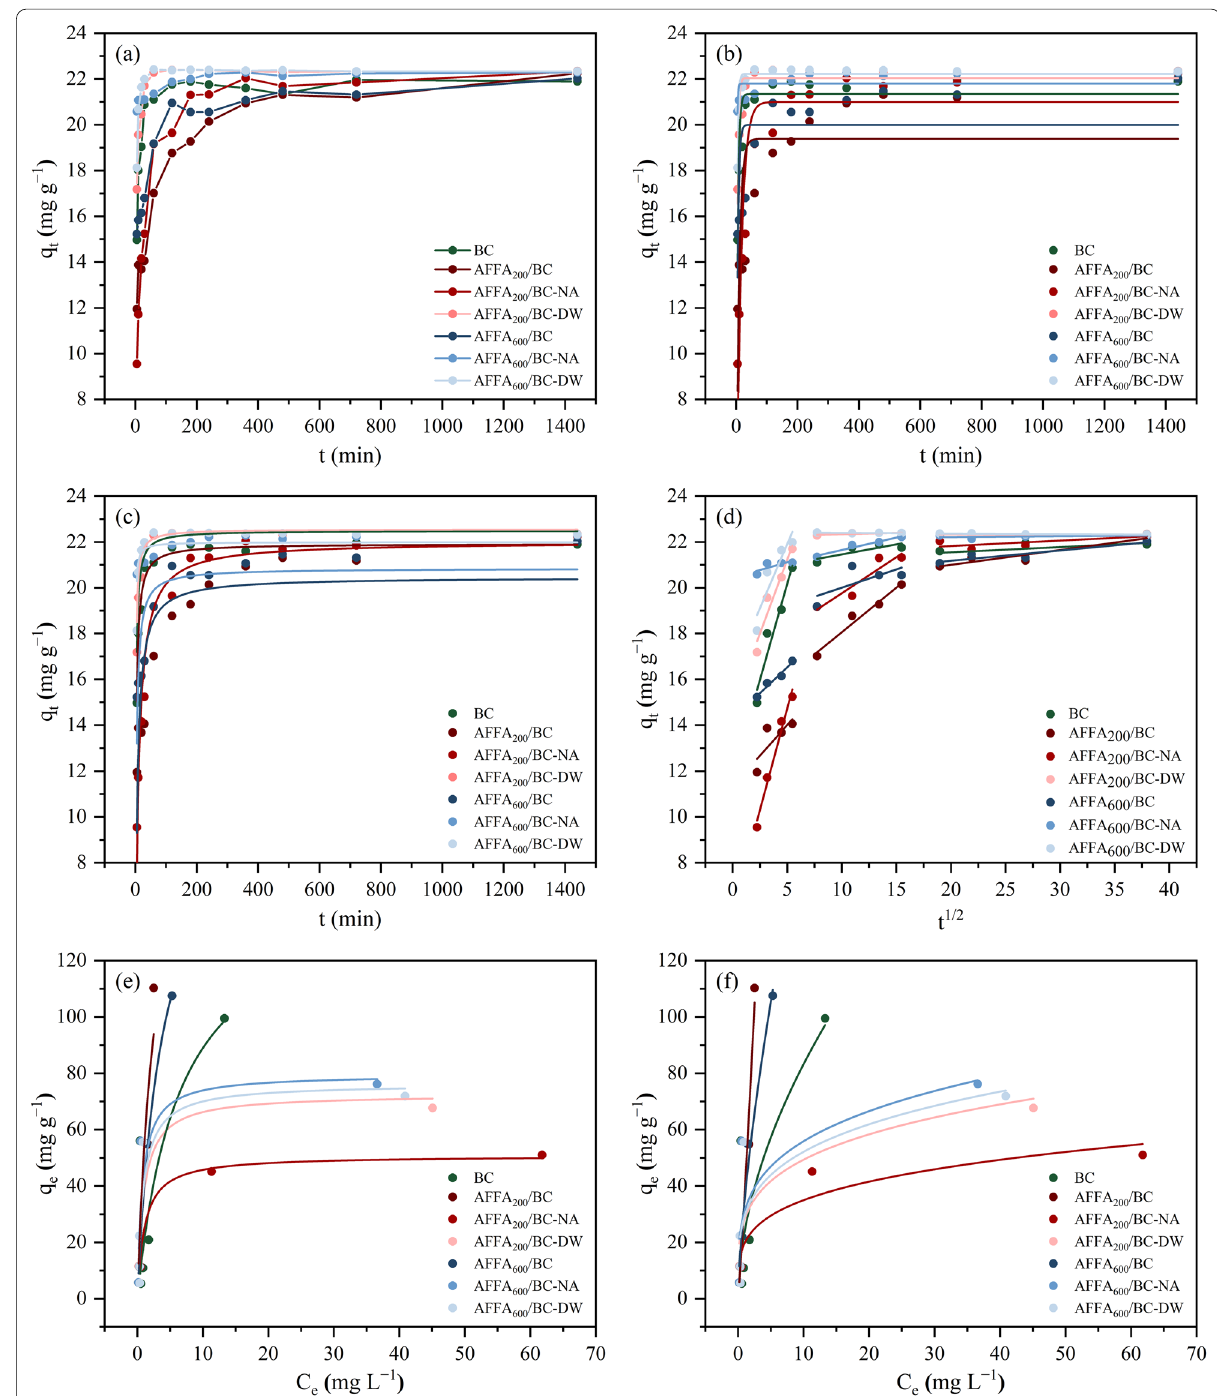
Fig. 6 a Influence of contact time on Pb(II) adsorption; b pseudo-first-order kinetic model; c pseudo-second-order kinetic model; d intra-particle diffusion model fitting curves of Pb(II) removal by BC and AFFA/BC (Pb(II) initial concentration temperature 25 ℃ ); e Langmuir and f Freundlich adsorption isotherms of different BCs for Pb(II) adsorption (dosage = temperature 25 ℃ , and time 24 = =